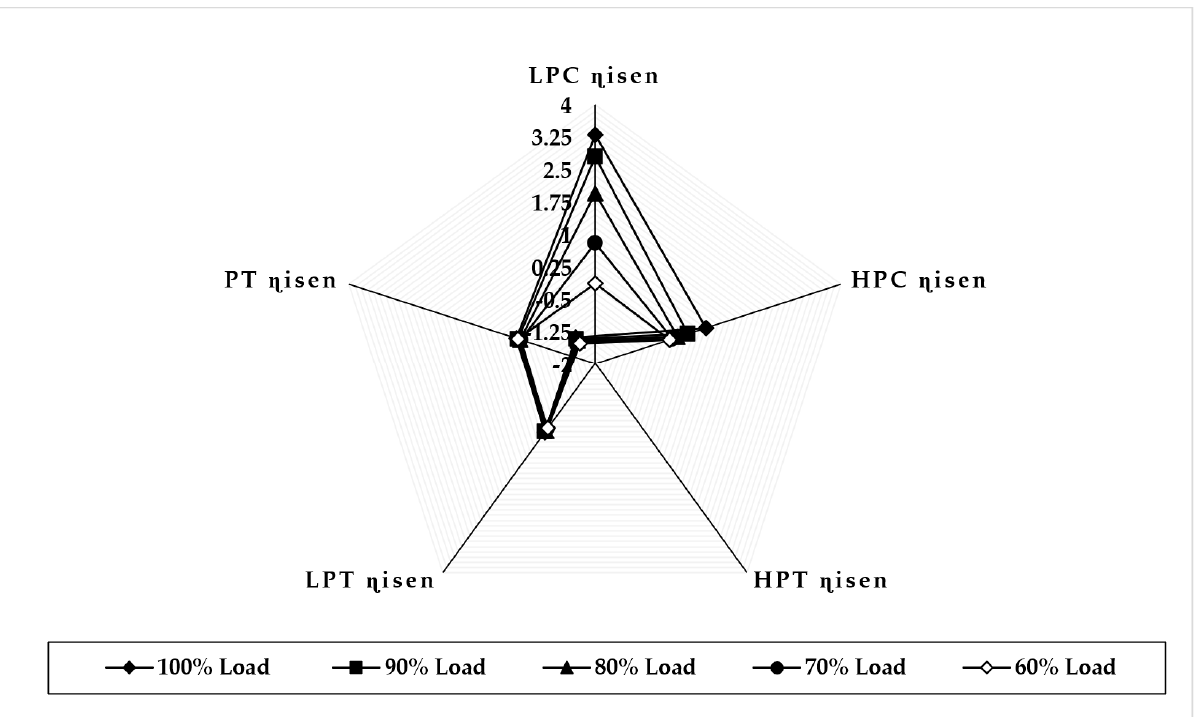
Figure 12. Deviation in component isentropic efficiency due to HPT erosion at 100% fault severity at full − load and part − load